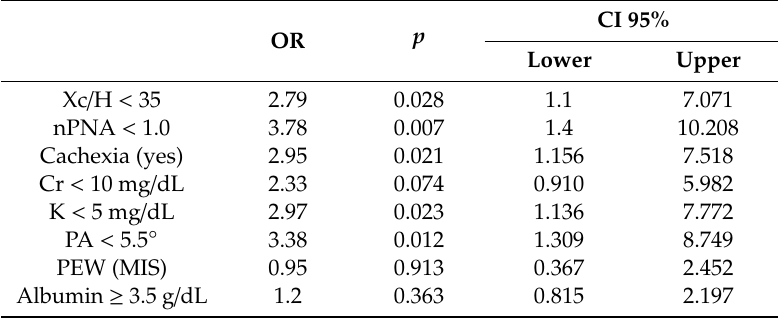
Table 6. Odds ratio for normouricemic patients to present